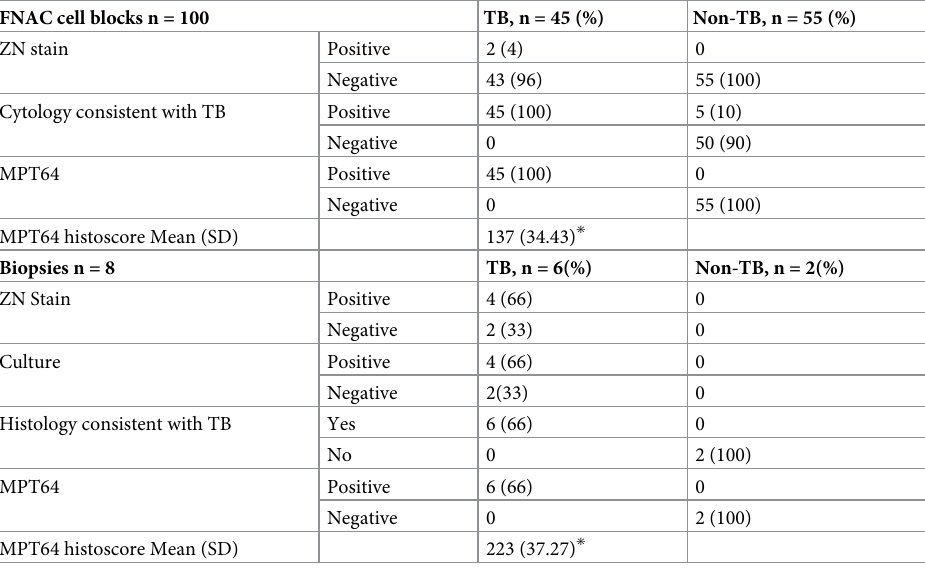
Table 3. Different diagnostic tests among TB and non-TB cases.